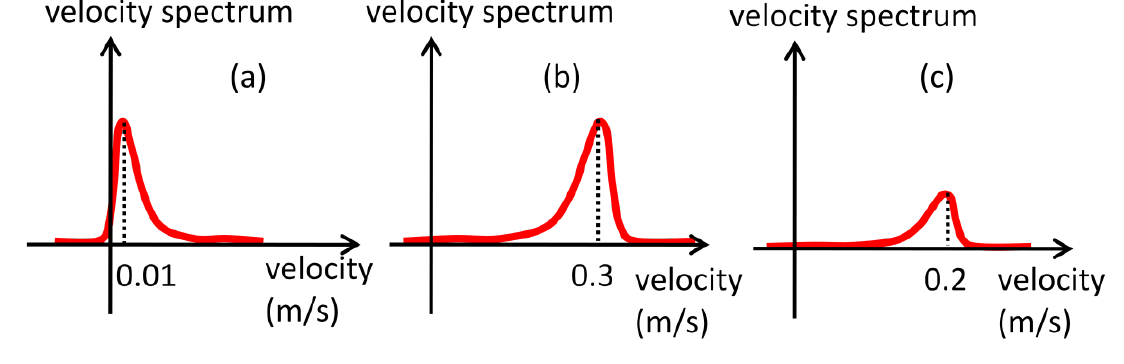
Figure 8. ( a ) Velocity spectrum for particles near the transducer. ( b ) Velocity spectrum for bubbles. ( c ) Velocity spectrum for particles far from transducer and in the bubble raster